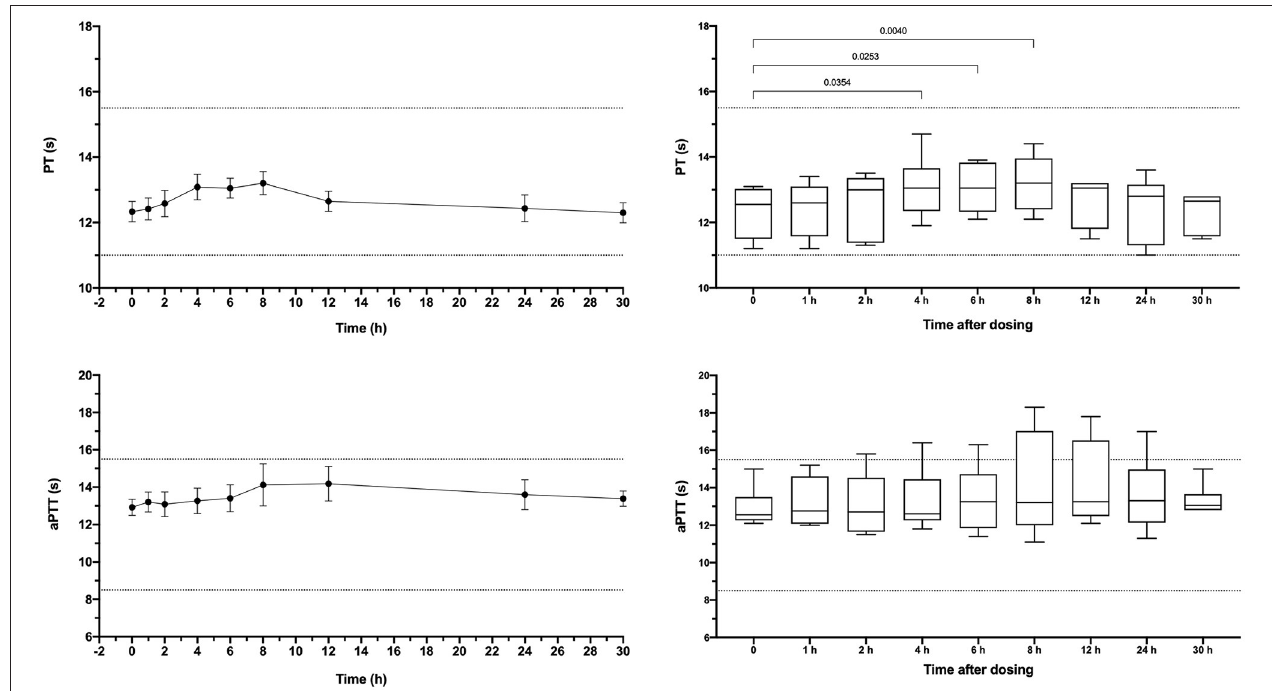
FIGURE 6 | Dotplots and box-whisker plots representing the prothrombin time (PT) and activated partial thromboplastin time (aPTT) values following oral administration of apixaban (0.2 mg/kg). Data presented on the left panels represent mean ± standard deviation values, while data on the right panels represent median (middle line), 25–75% percentile (box) and min-max (whiskers) for each time point. Dotted horizontal lines represent the upper and lower bounds of the laboratory reference interval. For the box-whisker plots, comparisons between baseline and subsequent time points were conducted using the Friedman test with Dunn’s post-hoc correction for multiple comparisons. Only those comparisons that attained P < 0.05 are